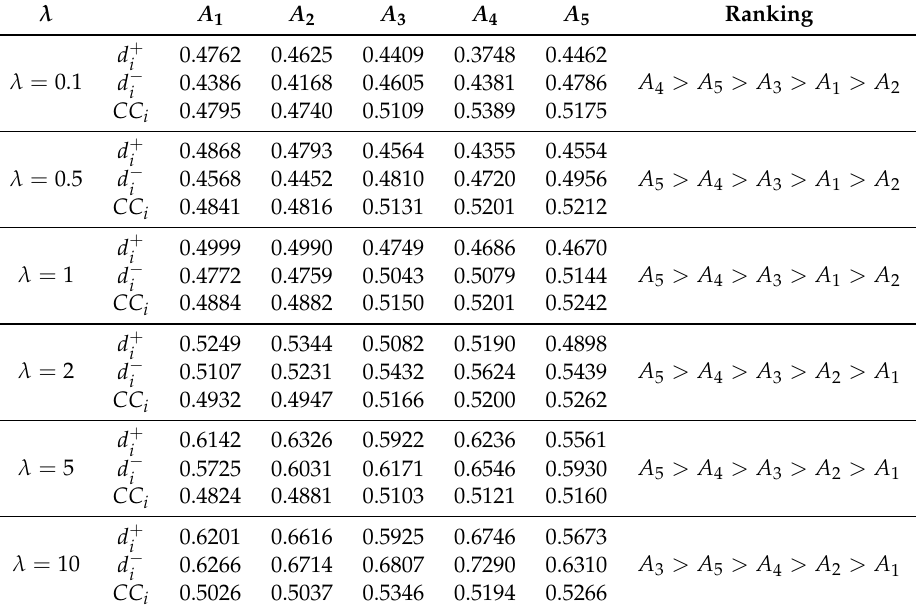
Table 6. Decision results using different λ with hesitant neutrosophic linguistic elements